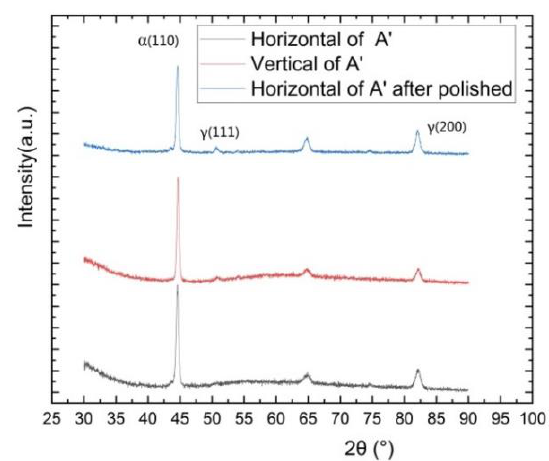
Figure 16. XRD analysis of the as-fabricated and polished MS specimens.